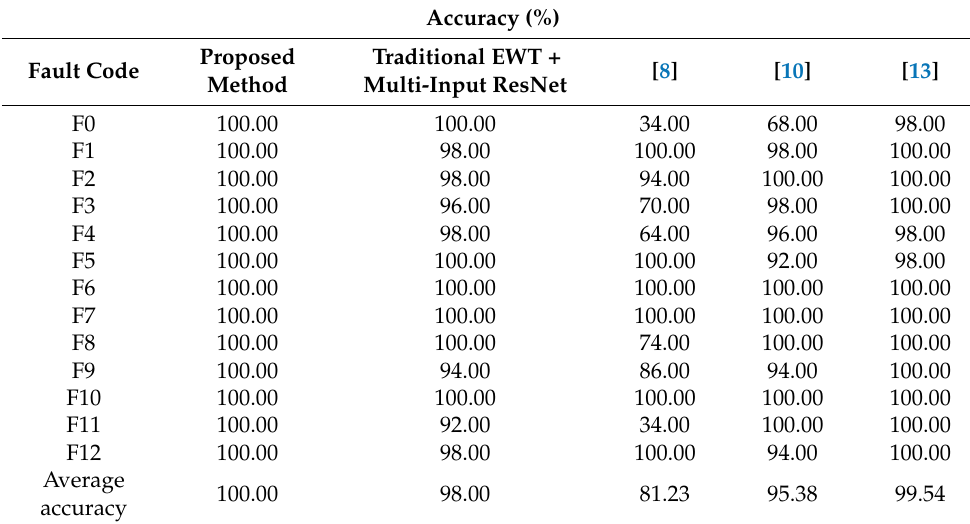
Table 5. Fault diagnosis result of the Sallen–Key bandpass filter circuit.